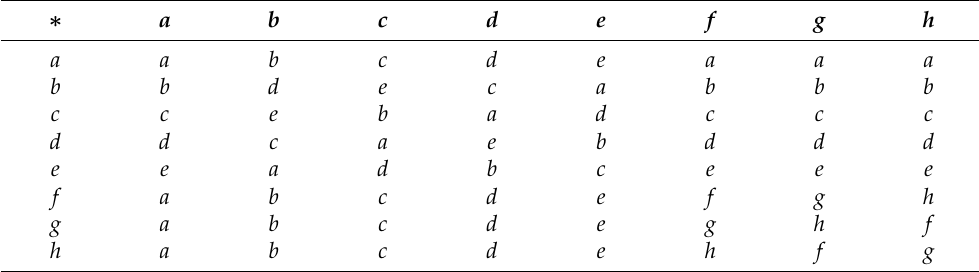
Table 10. A left transposition regular TA-groupoid with one identity element of Example 8.